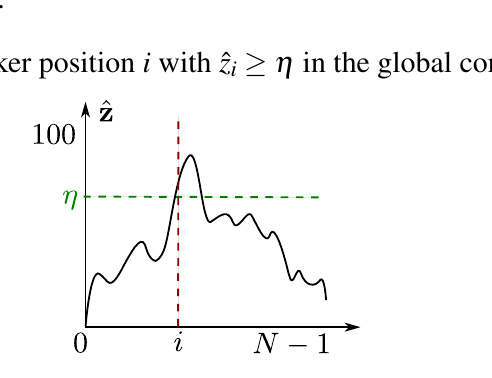
Figure 12. Detected marker position i with ˆ z